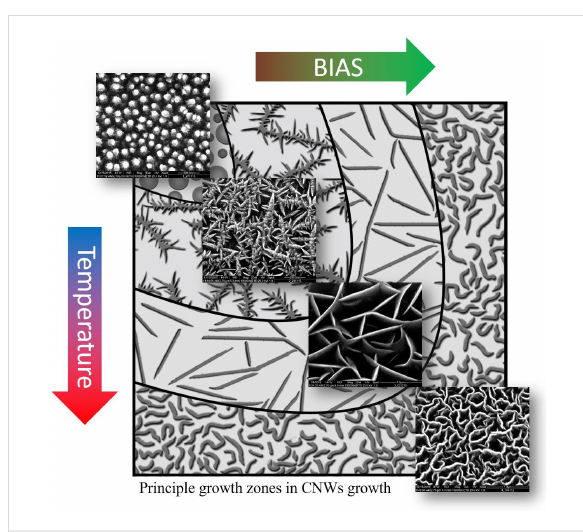
Figure 5: Growth zones of CNW growth: nanorods (low energies), thorny structures and straight CNWs (medium energies) and curled CNWs (high